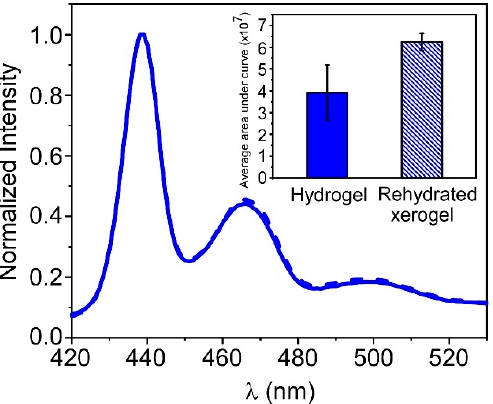
Figure 6. Normalized fluorescence emission spectra of PFO@AETA hydrogels (solid line) and rehydrated xerogels (dashed line). Inset: Average area under the (non-normalized) spectrum of different portions (n = 3) of hydrogels and rehydrated xerogels ( 𝜆 x = 396 nm). Error bars represent the standard deviation of the three replicates.